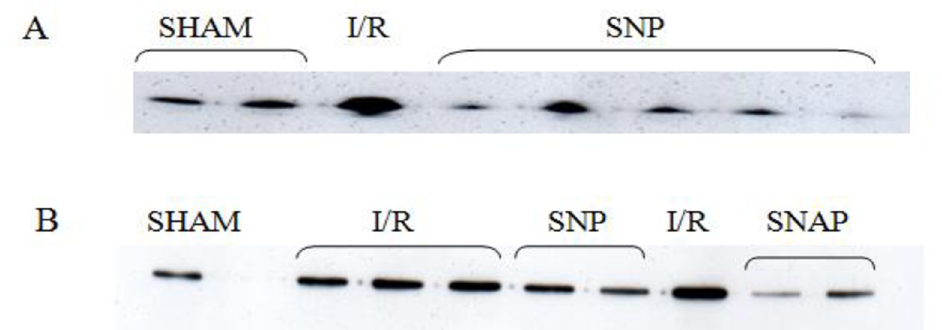
Fig 4. Western blots of cytosolic Thioredoxin and Thioredoxin reductase. Representative western blots used for the protein estimations of cytosolic thioredoxin (A) and cytosolic thioredoxin reductase (B). doi:10.1371/journal.pone.0159951.g004 with 2 μ M SIN-1 generated the lowest Msr activities (4591 ± 304). These findings are in line with the observed increase in infarct sizes in the 2 μ M SIN-1 perfused hearts. As perfusion with 10 μ M SNAP resulted in a significantly reduction in infarct size (Fig 3), additional time points along this perfusion protocol were investigated. 10 μ M SNAP had a profound stimulatory effect on the Msr activity at each time point along the protocol. Immediately after completion of the perfusion with SNAP (Pre-Ischemia), the Msr activity was approximately two fold (11277 ± 238; p < 0.01) higher compared to untreated hearts (5833 ± 711). This higher Msr activity was maintained during the ischemic period (11820 ± 647; p < 0.01 vs. I/R). The proteins levels of Trx and TrxR were determined by western blot analyses and are shown in Fig 4 and Table 3. Heart subjected to I/R (3.66 ± 0.36 AU.), showed an 8-fold increase in Trx levels compared to SHAM treated hearts (0.46 ± 0.16 AU.; p < 0.01 vs. I/R). All NO- donors prevented this increase and had significantly lower Trx proteins levels compared to I/R treated hearts (p < 0.01). Among the NO-donors, hearts perfused with 2 μ M SIN-1 had the highest Trx protein levels at the end of reperfusion (Table 3). The Pre-Ischemic protein level of Trx, was found to be significantly higher after perfusion with 10 μ M SNAP (2.47 ± 0.17 AU.; p < 0.01) compared to untreated hearts (0.42 ± 0.05 AU.) During the subsequent I/R the Trx protein level dropped to (0.66 ± 0.06 AU., p < 0.01 vs. I/R). Hearts perfused with 10 μ M SNAP also significantly lowered TrxR protein levels (2.42 ± 0.16 AU.) levels at the end of reperfusion compared to hearts treated by I/R alone (4.94 ± 0.87 AU.; p < 0.01). None of the other Table 3. Thioredoxin and thioredoxin-reductase protein levels. Protocol